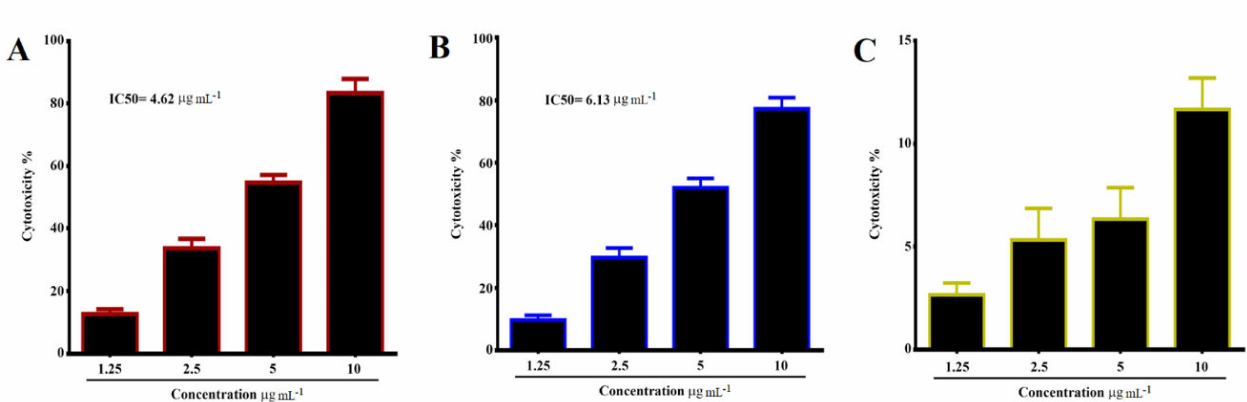
Figure 10. Growth inhibition of ( A ) MCF-7, ( B ) CAL-51 human breast cancer cell lines treated with different concentrations (1.25, 2.5, 5, and 10 µ g mL − 1 ) of TAM/RES–LbL-LCNPs. IC 50 value for MCF-7 was 6.13 µ g mL − 1 and CAL-51was 4.62 µ g mL − 1 , and ( C ) WRL-68 normal human liver cell